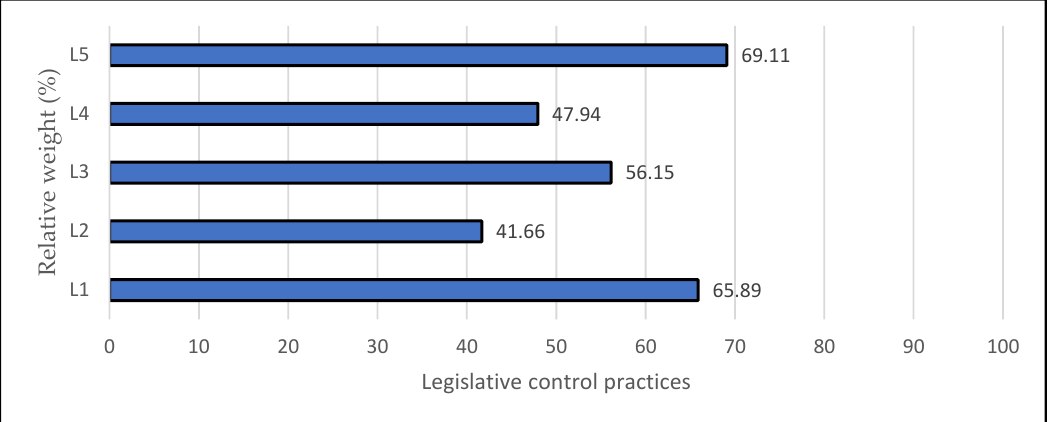
Figure 3. Farmers’ adoption of legislative control practices for red palm weevil control. (L1 = adhering to the measure against transferring infested trees or offshoots to non-infested areas, L2 = burning and burying the infested palm far away after cutting it into small portions, L3 = adhering to the measure against transferring infested palm waste to other areas, L4 = surveying RPW-infested palms and informing the authorities when necessary, L5 = not allowing anyone to transfer infested offshoots from an infested farm).